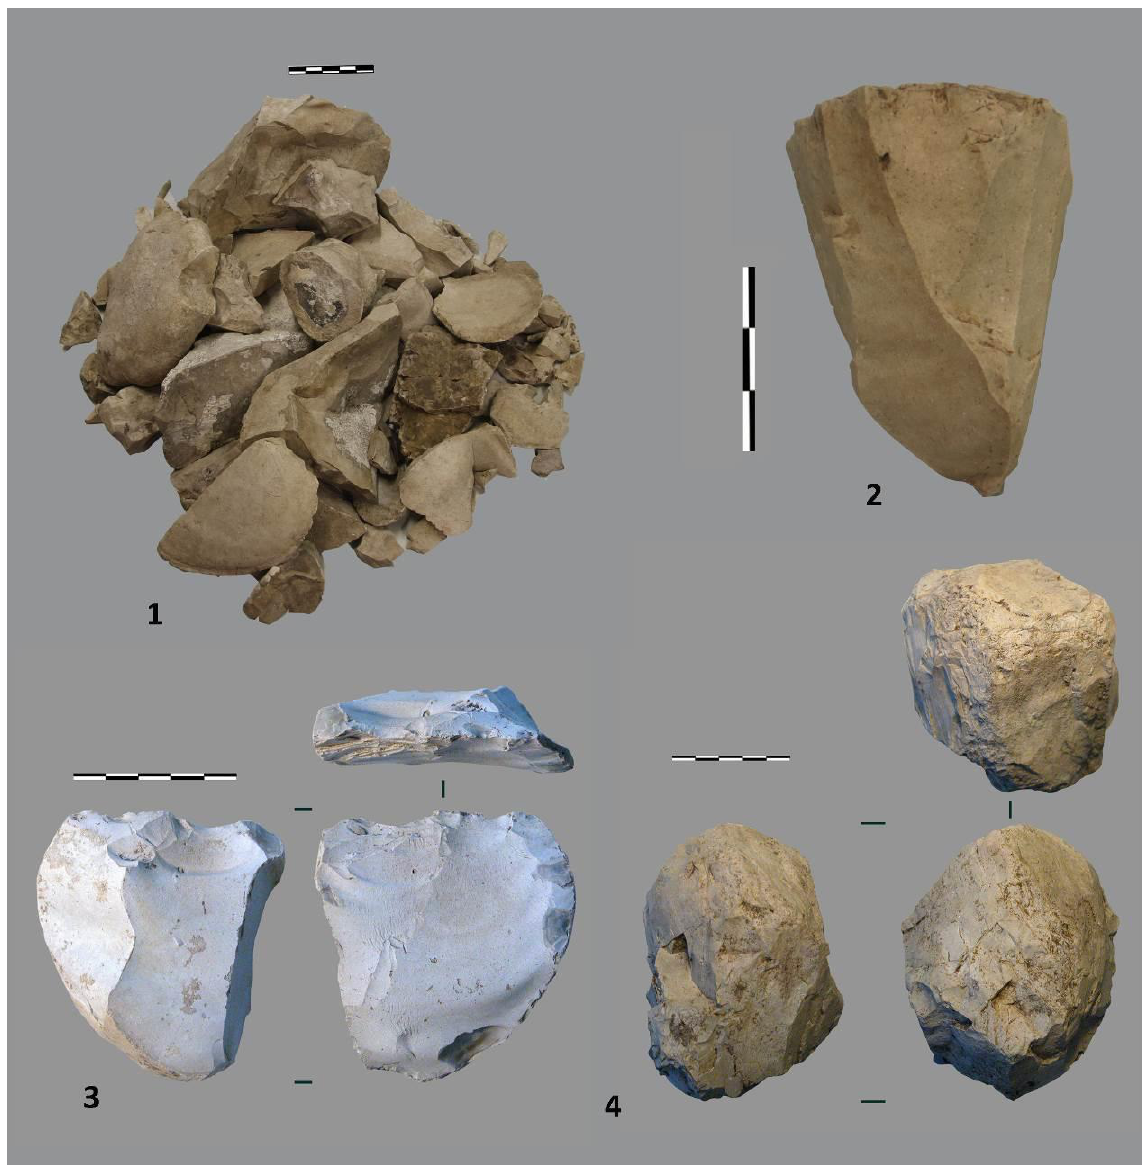
Figure 15. Photograph showing 1) the diversity of lithic material and products of large size and with cortex. 2) Pyramidal core. 3) A wedge - a retouched product that is related with the mining activity of nodules extraction. 4) A core turned into a